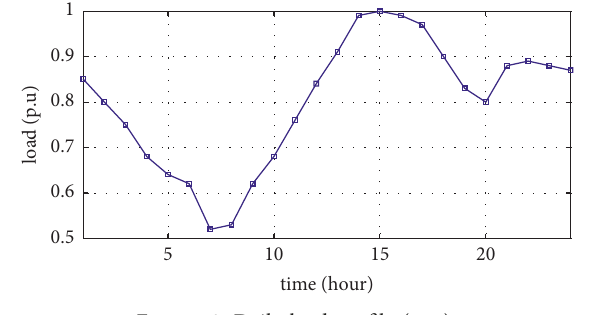
Figure 8: Daily load profile (p.u.).